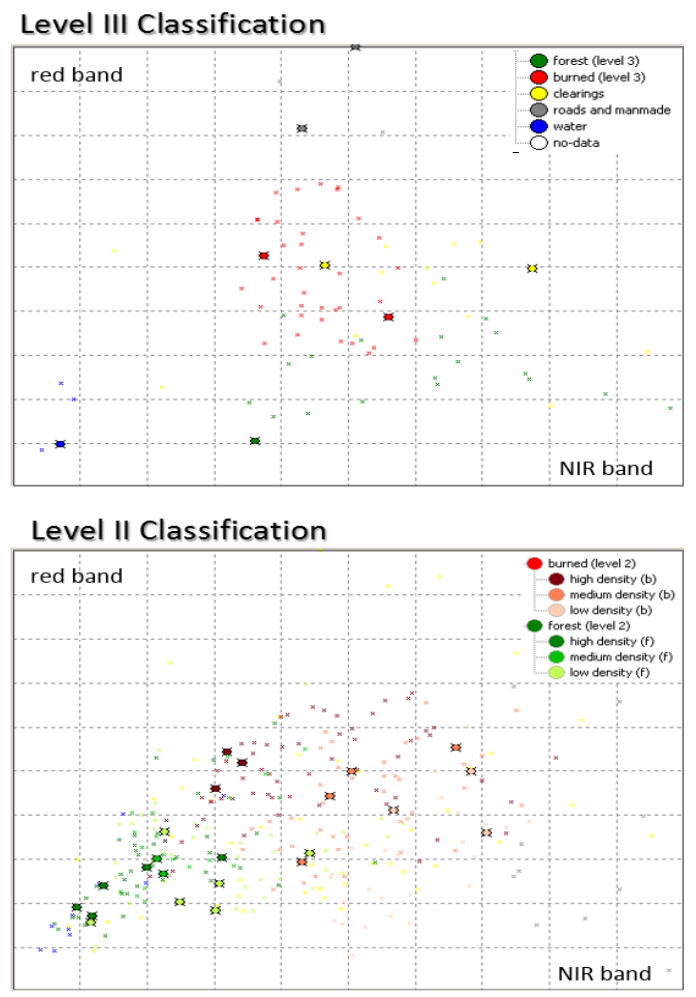
Figure 8. Feature space plots (NIR and red bands) for assessment sites at the three hierarchical levels of